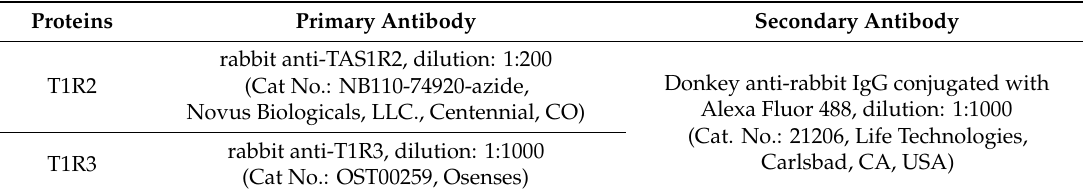
Table 3. Antibodies used for